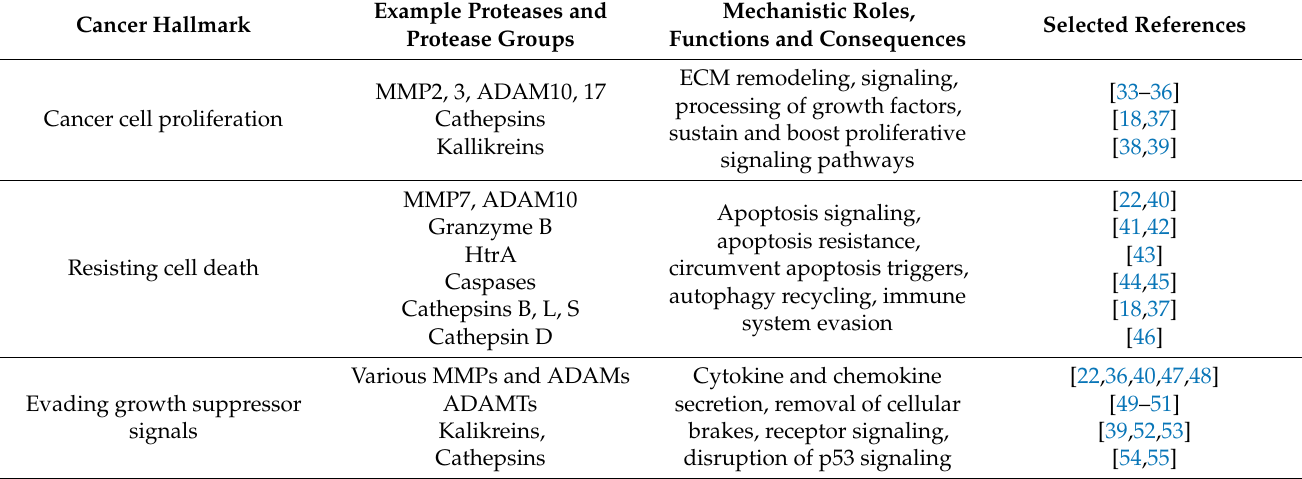
Table 1. Protease roles in the context of cancer hallmarks. Representative examples and selected roles of the most important proteases and protease groups are described with respect to cancer development and